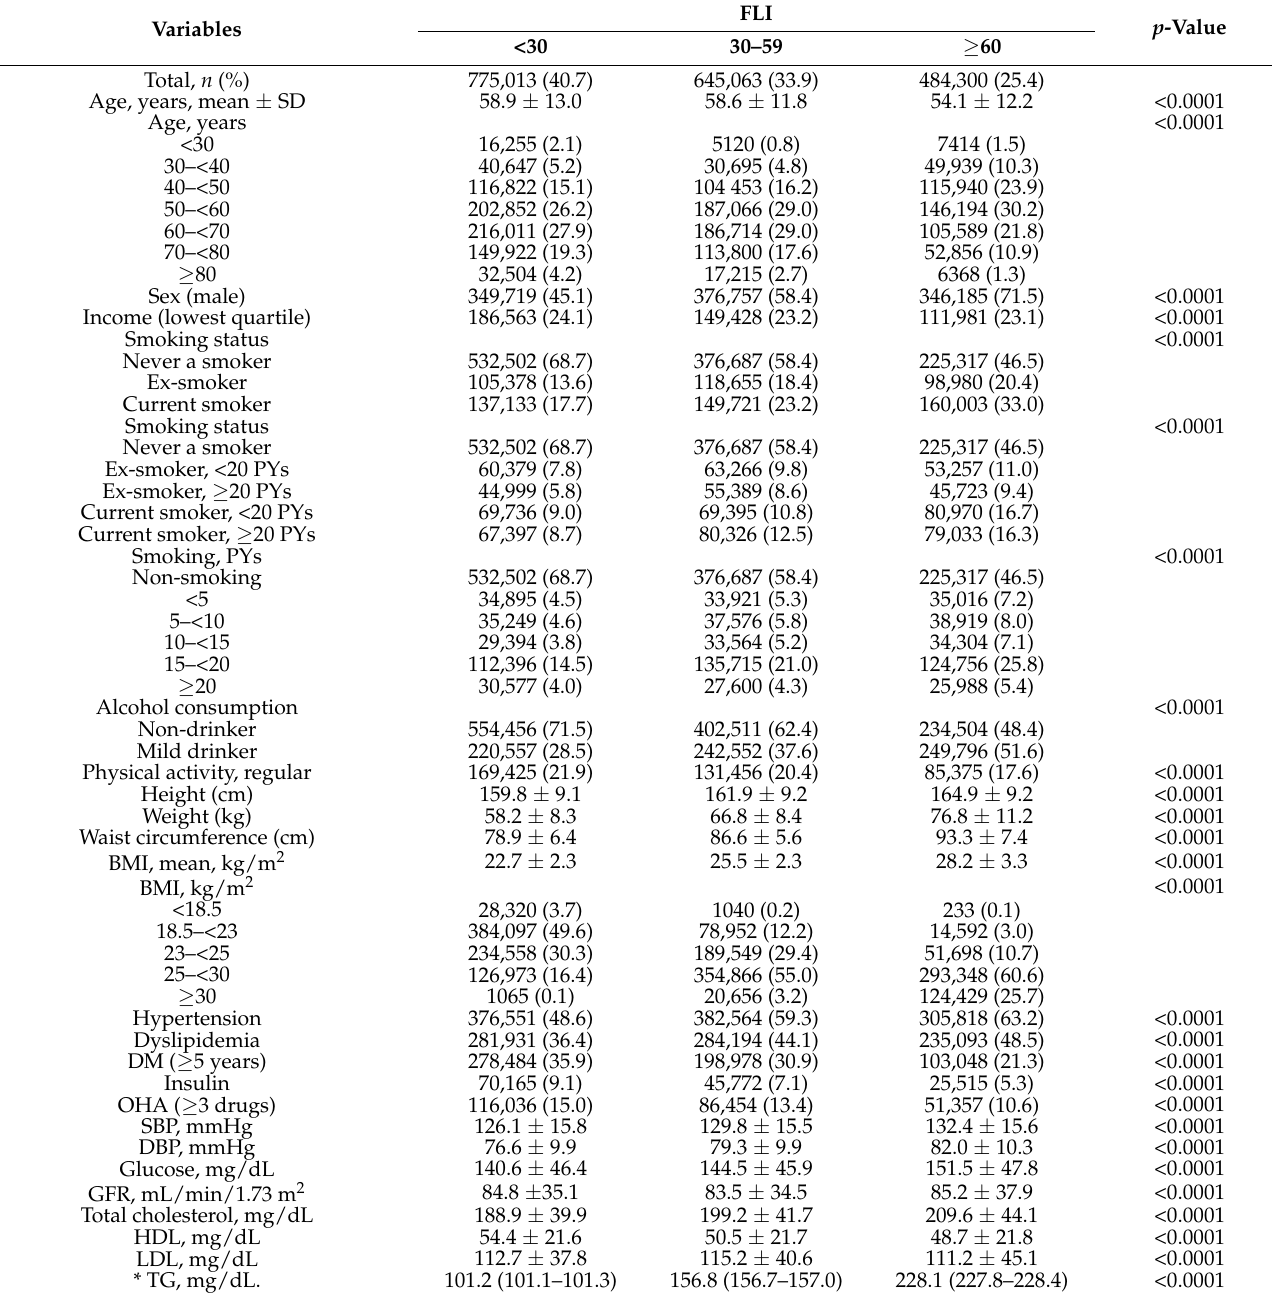
Table 1. General characteristics of the subjects based on the risk of fatty liver among DM